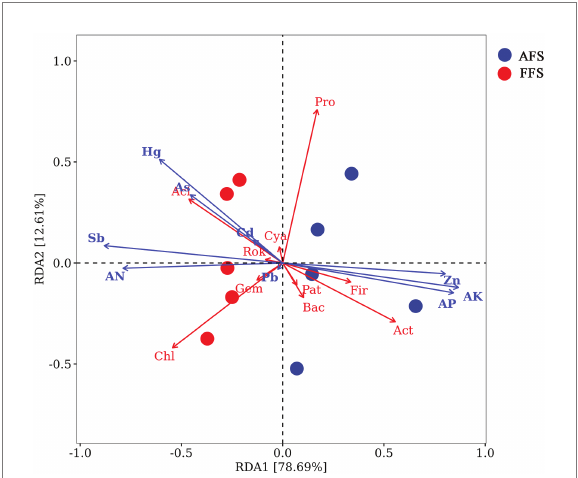
FIGURE 6 Redundancy analysis (RDA) of bacterial communities using soil properties as environmental parameters in the FFS and the AFS. The different colored points represent the two different types of management. The arrows represent soil properties, including available phosphorus (AP), available nitrogen (AN), and available potassium (AK). The two different circle colors represent FFS and AFS. On the RDA axis, the relationships between environmental variables and the axis were determined by arrow length and angle size. AK, available K; AN, available N; AP, available P; Aci, Acidobacteria; Act, Actinobacteria; Bac, Bacteroidetes; Chl, Chloroflexi; Cya, Cyanobacteria; Fir, Firmicutes; Gem, Gemmatimonadetes; Rok, Rokubacteria; Pat, Patescibacteria; and Pro,